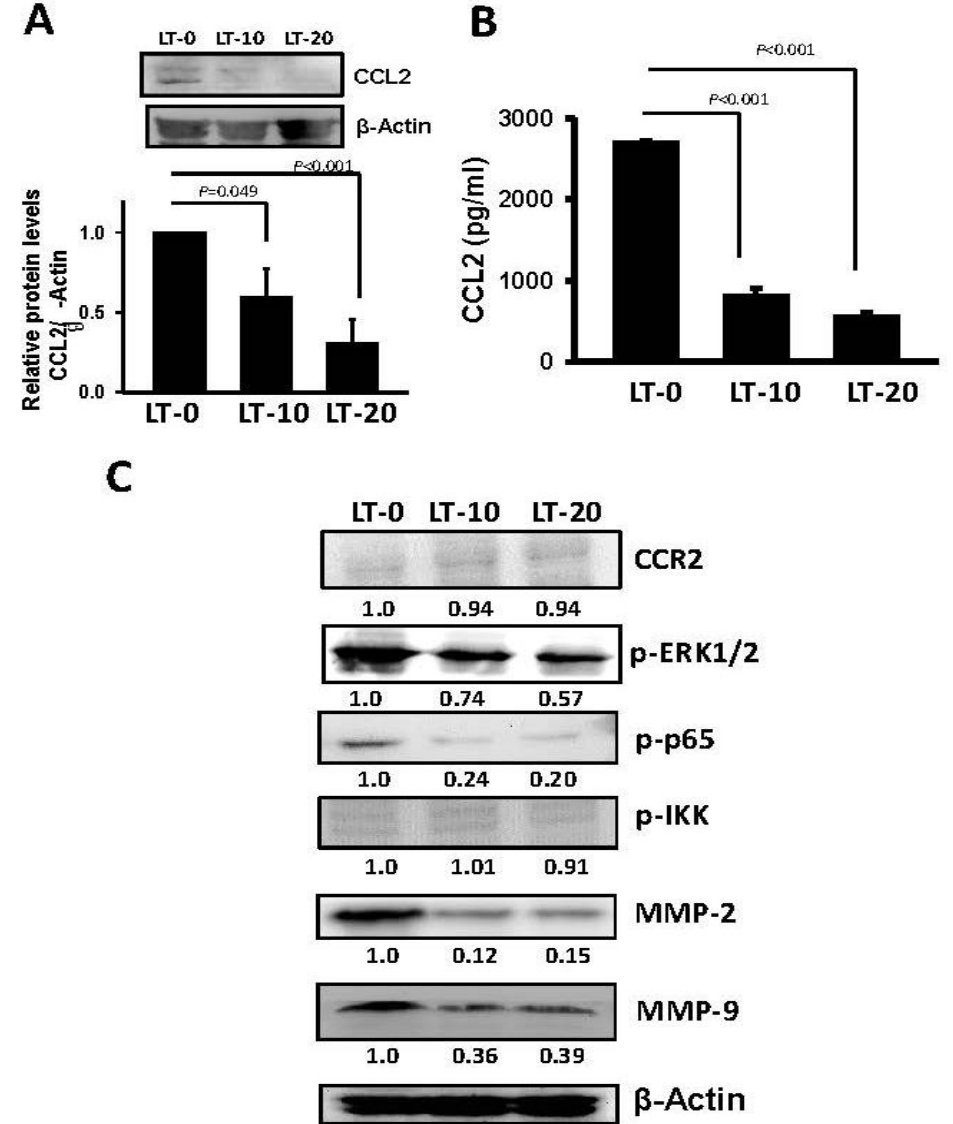
Figure 5. Long-term exposure to Oro-A downregulates CCL2 signaling. ( A ) The protein level of CCL2 was determined by western blotting. ( B ) The soluble form of CCL2 was examined with ELISA. ( C ) Western blotting was performed using antibodies against CCR2, phosphorylated (extracellular signal–regulated kinases 1/2) ERK1/2, phosphorylated p65, phosphorylated IKK, MMP2, and MMP9. β -Actin was used as the internal control. P values were determined using Student’s t test.